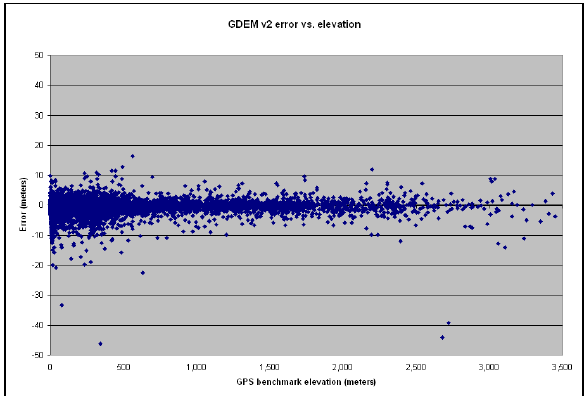
Figure 2. GDEM v2 measured errors plotted vs.